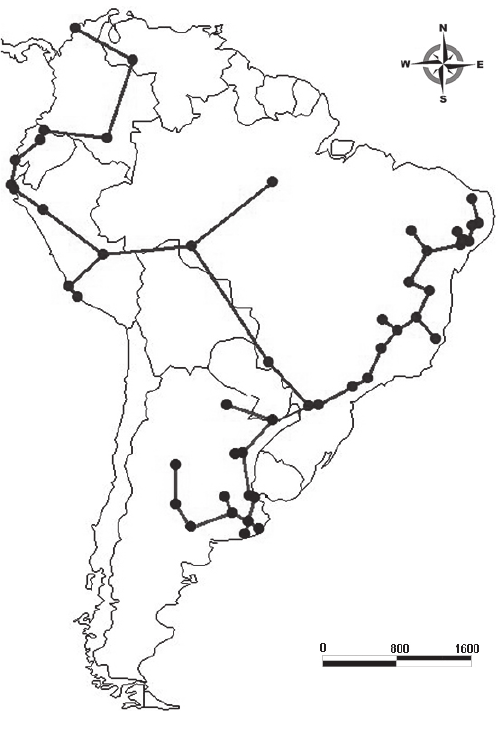
Fig. 13 - Individual tracks of Megatherium (1 - Megatherium medinae ; 2 – M. americanum ).